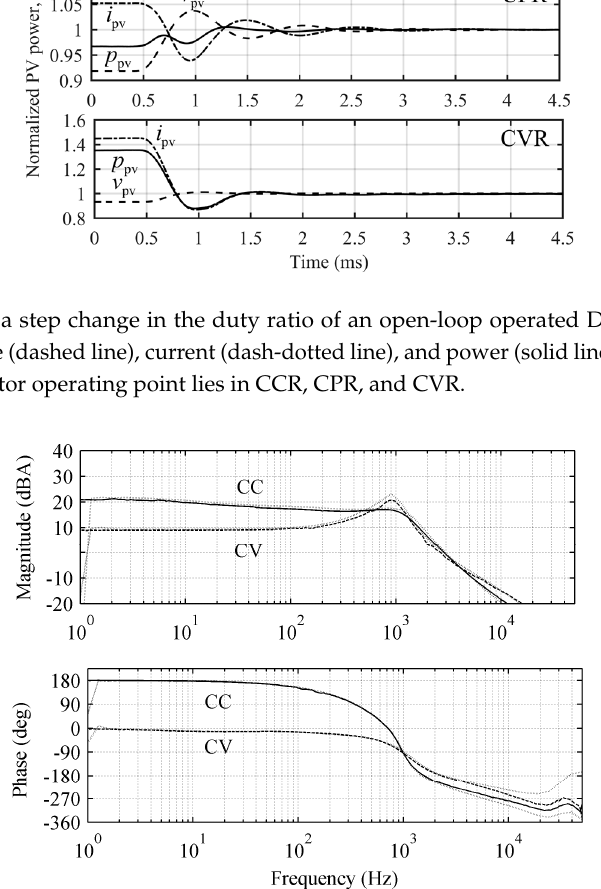
Figure 17. Measured control-to-output transfer functions ( G co-o ) of a boost-power-stage converter operating in CC and CV regions of Raloss SR30-36 PV panel.